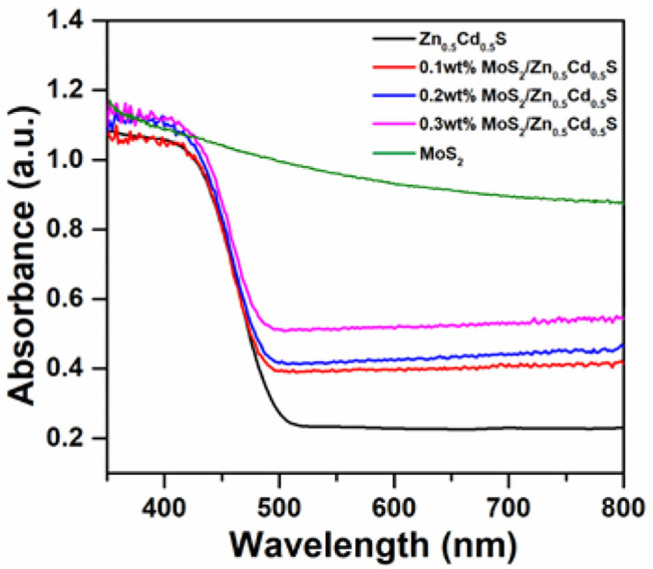
UV-vis spectra of pure MoS2 and MoS2/Zn0.5Cd0.5S with different molar fraction ratios.